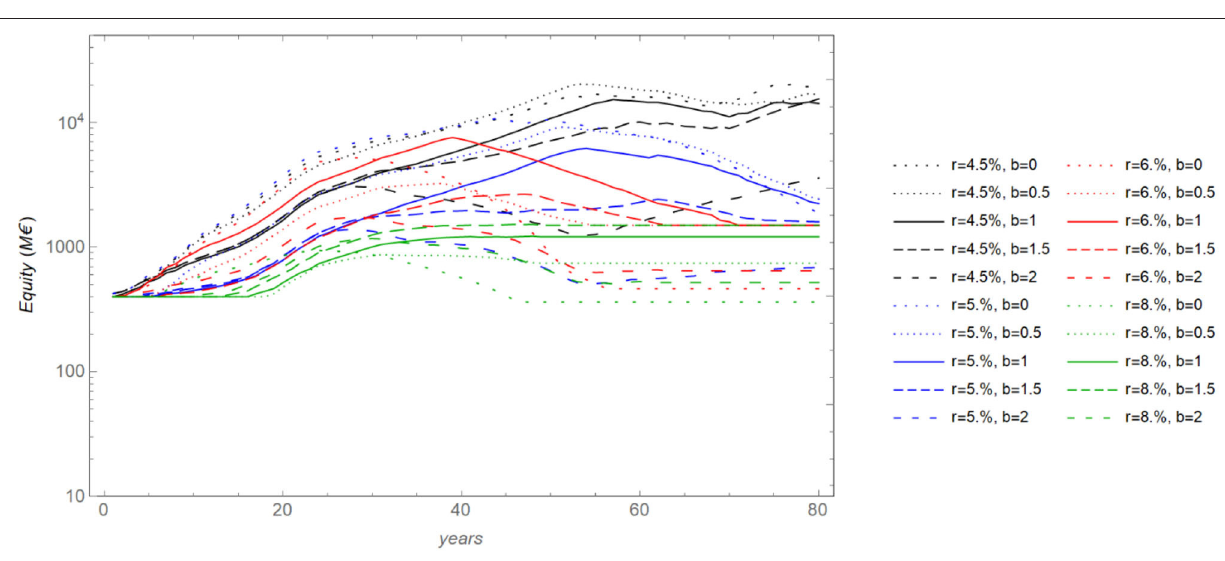
On the Level of Individual Agents Investments Results show that an agent’s capacity mix varies with different levels of access to capital ( f and i ). Overall, we observe that